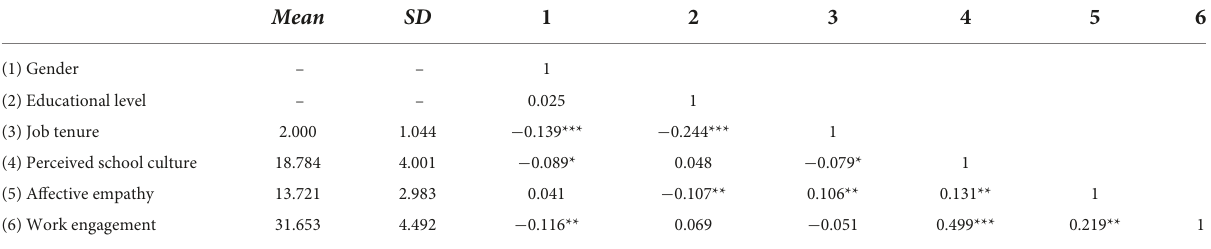
TABLE 1 Means, standard deviations, and correlations for study variables.